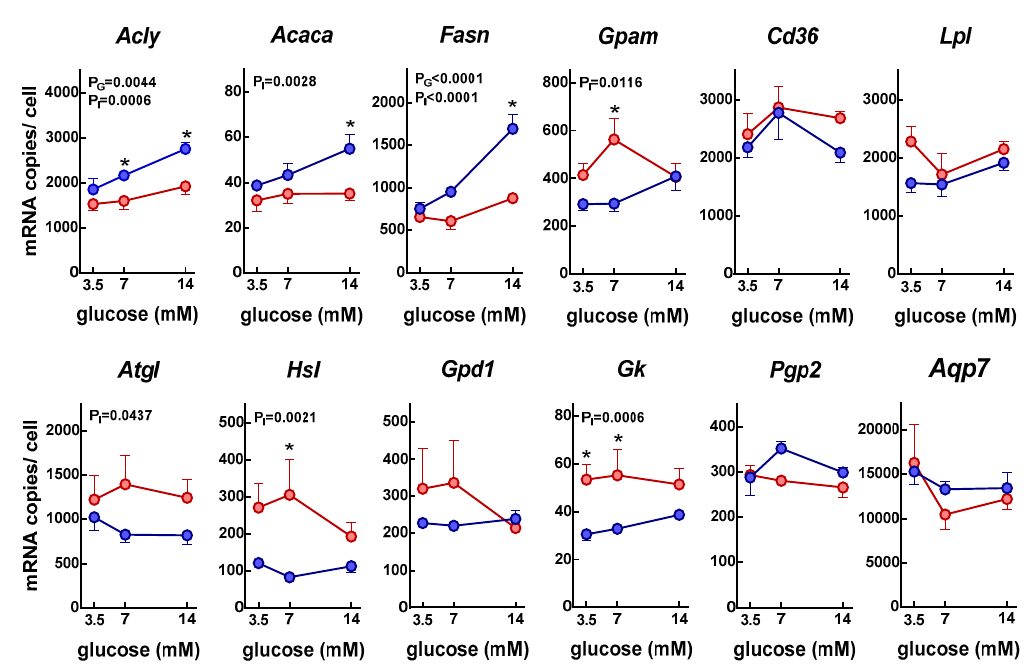
Figure 5. Insulin effect in gene expression of proteins related to lipids and glycerol metabolism in adipocytes incubated under varying glucose concentrations for 24 h. The data are presented as number of the corresponding mRNA copies per cell, and are mean ± SEM of data from six rats. The data were obtained from the “parallel” incubations (i.e., no label). Red circles: adipocytes incubated in absence of insulin; blue circles: adipocytes incubated in presence of insulin. The statistical significance data and conventions are the same as in Figures 1 and 4. The correspondence between gene names and those of the proteins they code can be seen in Table 1. *post-hoc significant differences between groups with and without insulin of identical glucose